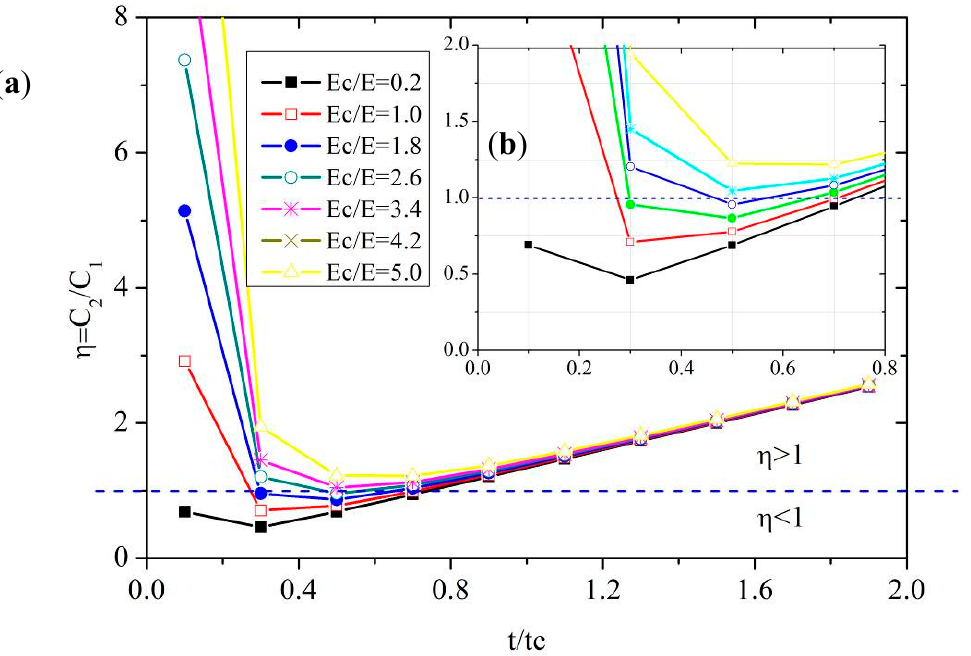
Figure 10. The relative sensitivity between cantilever and dual diaphragm type FPSs versus t / t c and E c / E : ( a ) a large-scale graph; ( b ) a small scale graph.